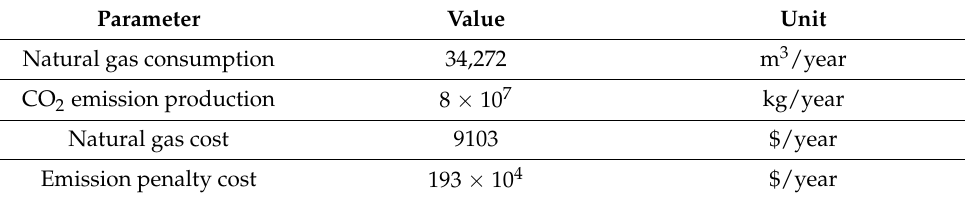
Table 8. Energy consumption, emission production and associated costs in the Abadan refinery